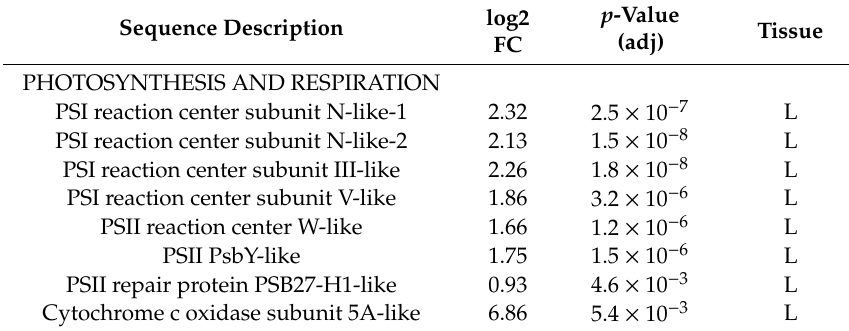
Table 4. Differentially expressed genes related to photosynthesis and respiration in tolerant vs. sensitive plants. Tissue column indicates tissue specificity of the tolerant vs. sensitive expression.